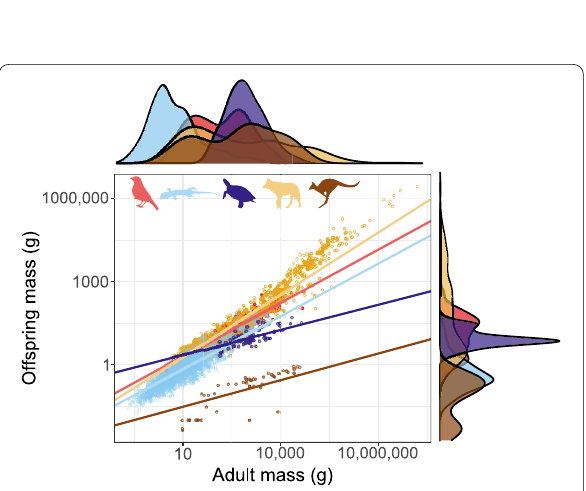
Fig. 3 Allometry of offspring size. Red: birds; blue: squamates; purple: turtles; yellow: placental mammals; brown: marsupial mammals. Solid lines are regression slopes from PGLS analysis. Both axes are log 10